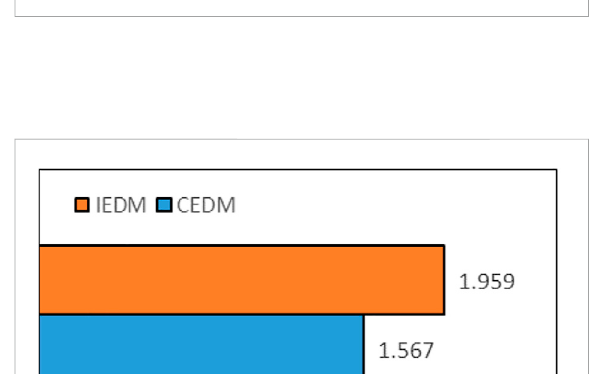
FIGURE 8 Supply water in two modes.